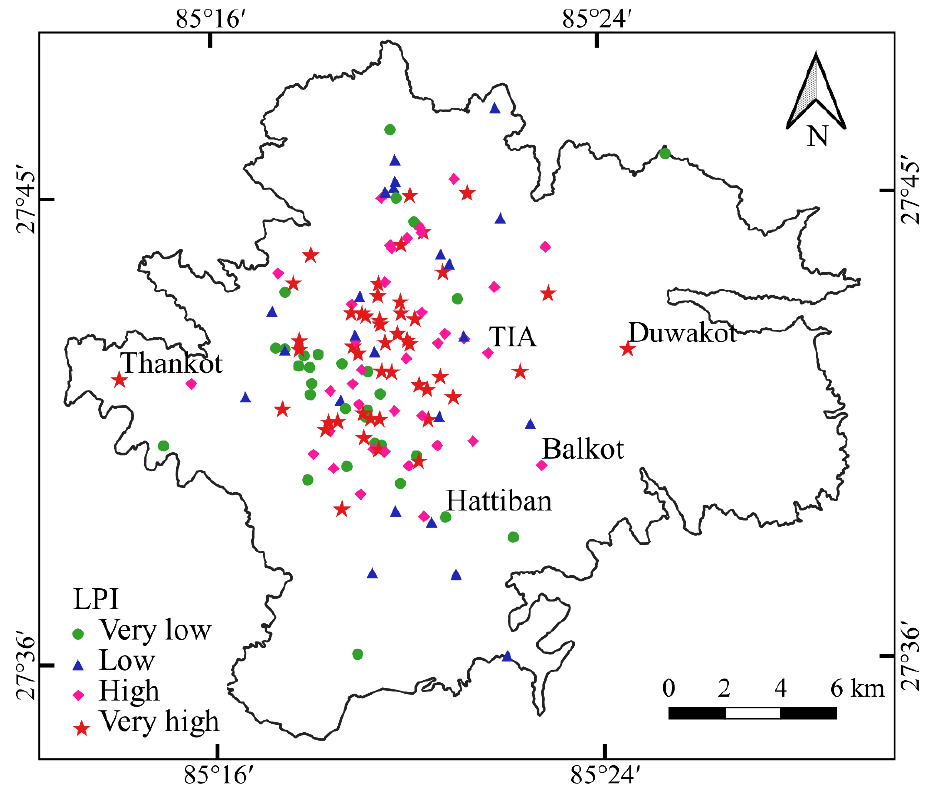
Figure 9. LPI for each borehole considered in this study.